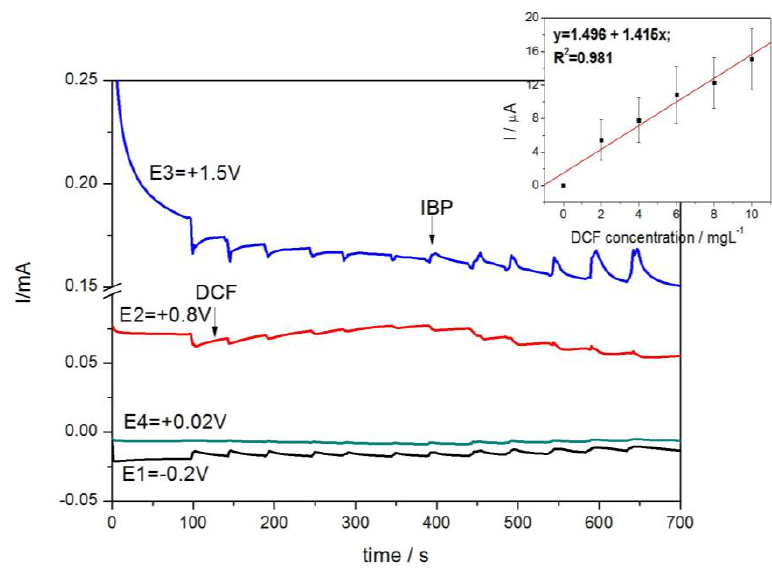
Figure 9. Multiple-pulsed amperograms recorded at HKUST-CNF electrode in 0.1 M Na 2 SO 4 supporting electrolyte and consecutively and continuously adding each of 2 mg·L −1 DCF and respective, IBP, recorded at E1 = −0.2 V/SCE, E2 = +0.8 V/SCE, E3 = +1.5 V/SCE, E4 = +0.02 V/SCE. Inset: Calibration plots of the currents recorded at E = +0.8 V vs. SCE versus DCF concentrations. Table 2. The electroanalytical parameters reached for the selective/simultaneous detection of IBP and DCF with a HKUST-CNF electrode.